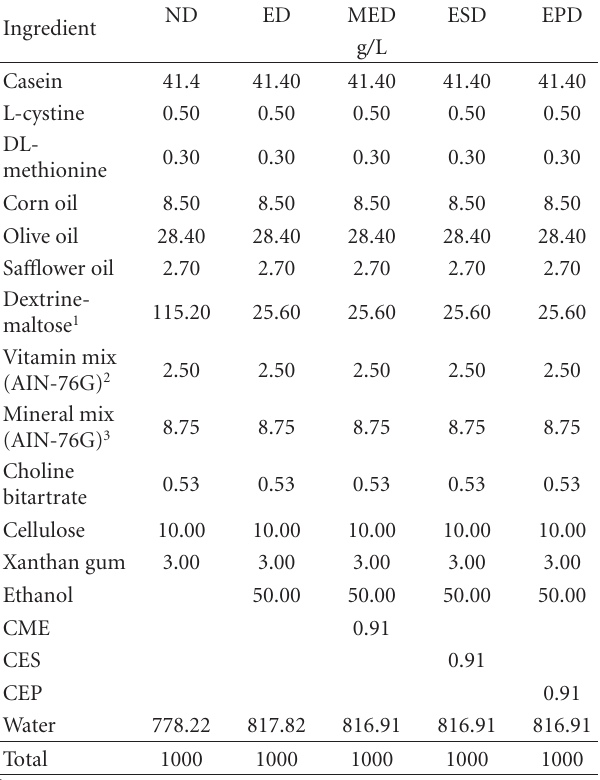
Table 1: Compositions of experimental